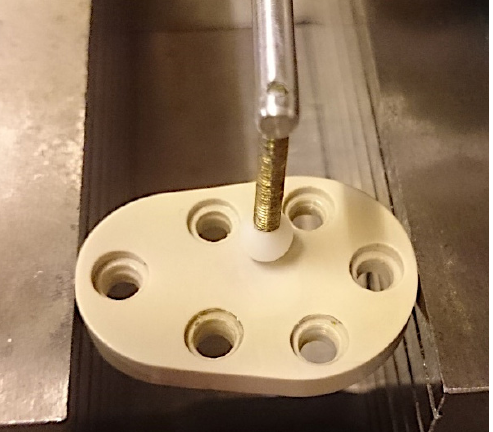
Figure 7. Measuring tip of the galvo scanner for tactile surface measurement.